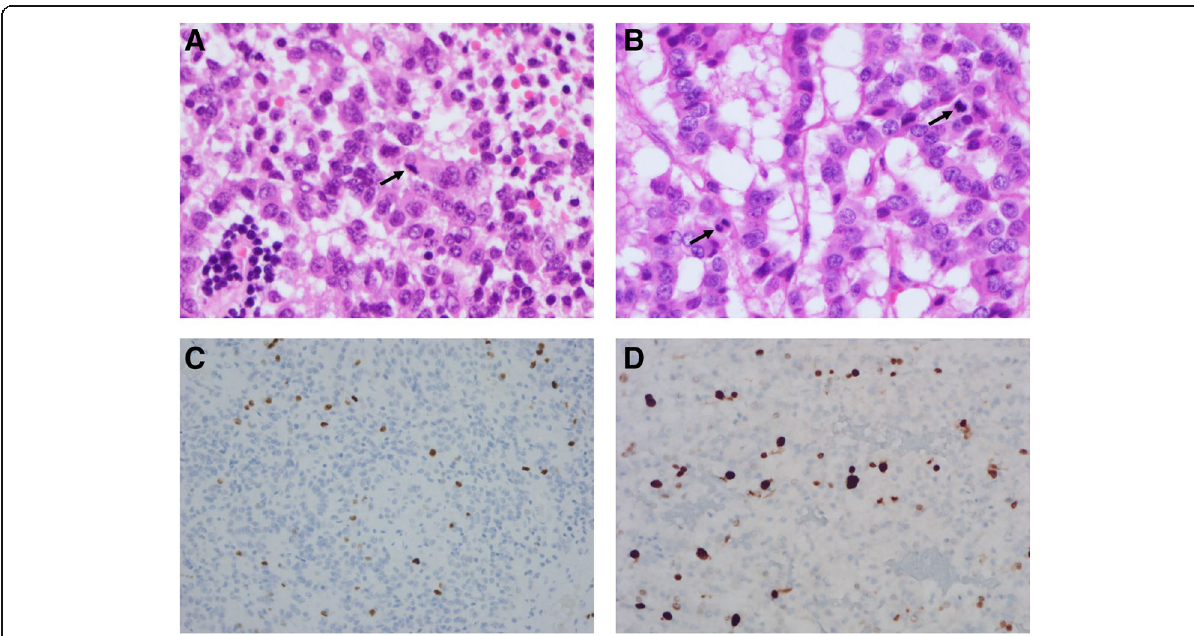
Fig. 3 Proliferative indices in cases with metastasis. Mitotic figures ( a , case no. 4, ×400; b , case no. 6, ×400) and Ki-67 immunostaining ( c , case no. 4, ×400; d , case no. 6, ×400) were observed